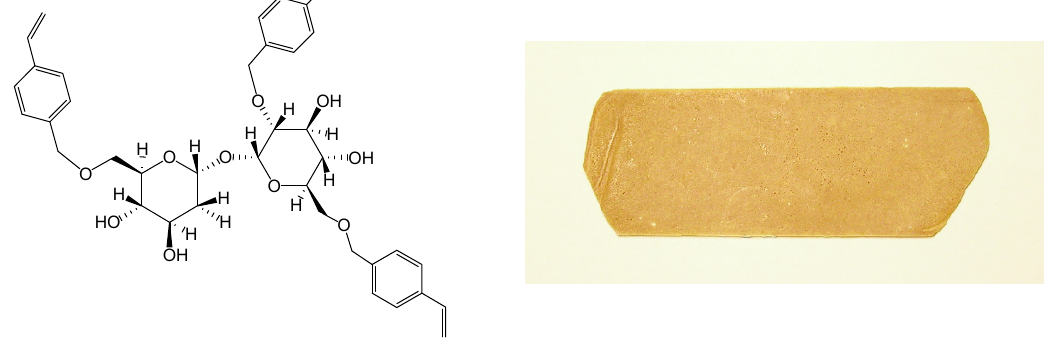
Figure 8. Typical structure of trehalose vinylbenzyl ether (left), and a photograph of the molded resin